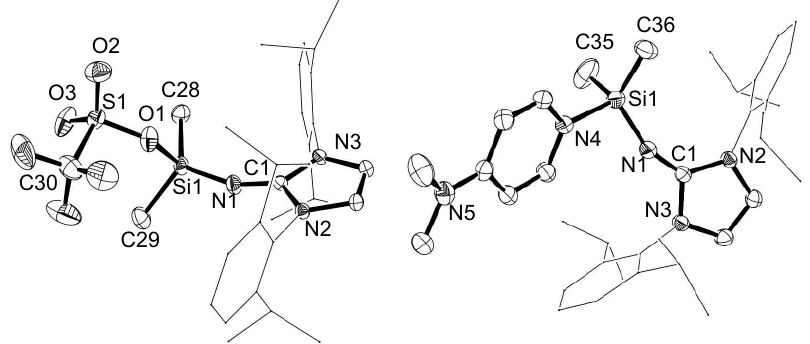
Figure 5. ORTEP representation of the molecular structures of 8 ( left ) and 9 ( right ) in the solid state. Thermal ellipsoids are at the 40% probability level. Hydrogen atoms are omitted for clarity. Dip groups are depicted as stick models. Selected bond lengths [Å] and bond angles [ ˚ ] for 8 : Si(1) − O(1)